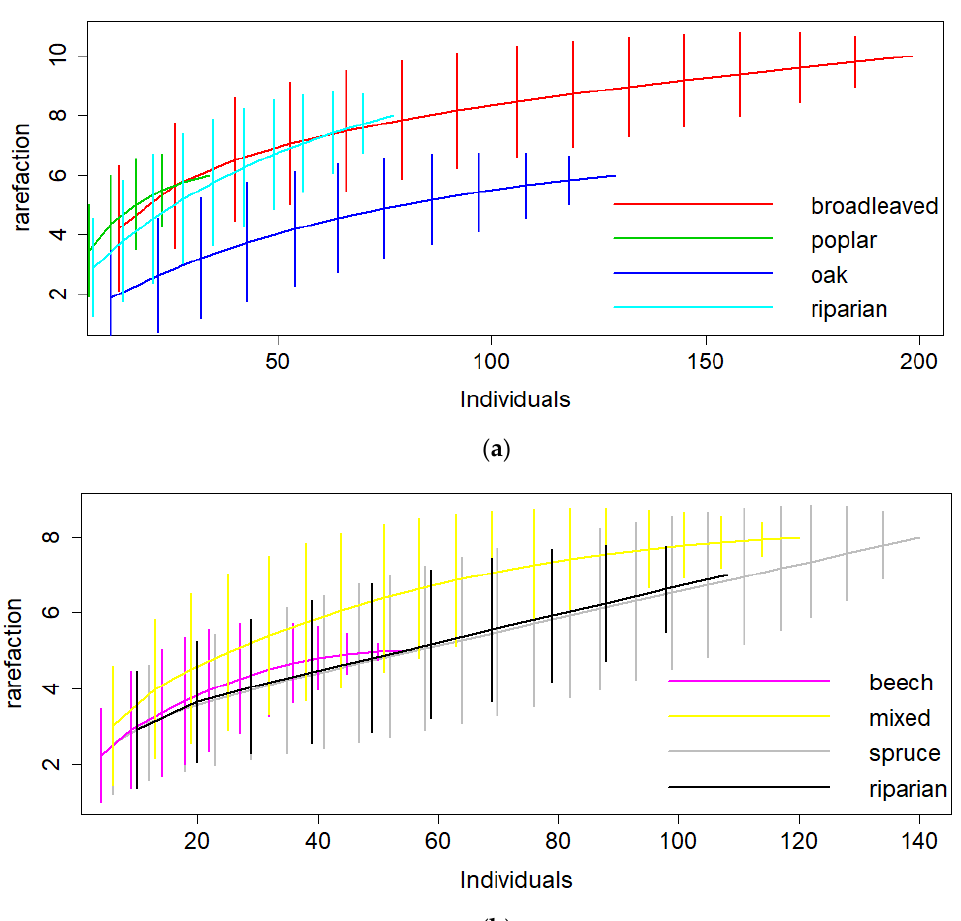
Figure 4. Rarefaction curves of small mammal species in the four forest types in ( a ) lowlands and ( b ) mountains. Vertical bars represent the 95% confidence interval of the estimated number of species.